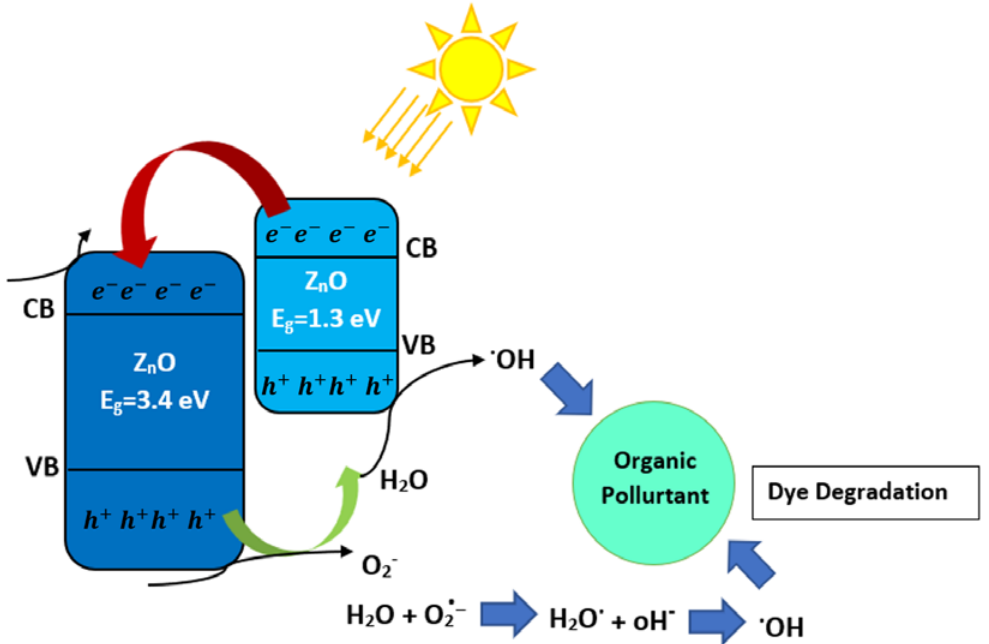
Figure 11. Schematic of a photocatalytic mechanism of ZnO/CuO